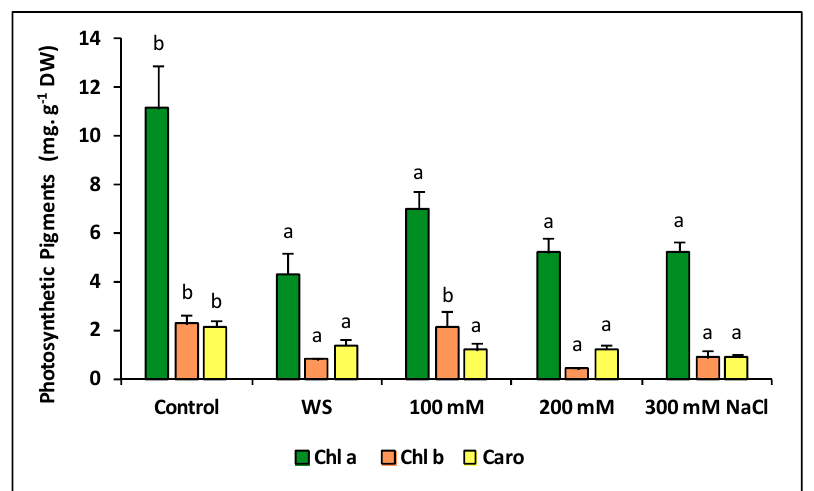
Figure 6. Photosynthetic pigments, chlorophyll a (Chl a), chlorophyll b (Chl b), and carotenoids (Caro) after 23 days of water stress (complete withholding of irrigation) and salt stress (at the indicated NaCl concentrations) treatments, in Thalictrum maritimum plants grown in controlled conditions in the greenhouse. Values shown are means ± SE ( n = 5). For each pigment, same lowercase letters over the bars indicate homogeneous groups between treatments according to the Tukey test ( p ≤ 0.05).